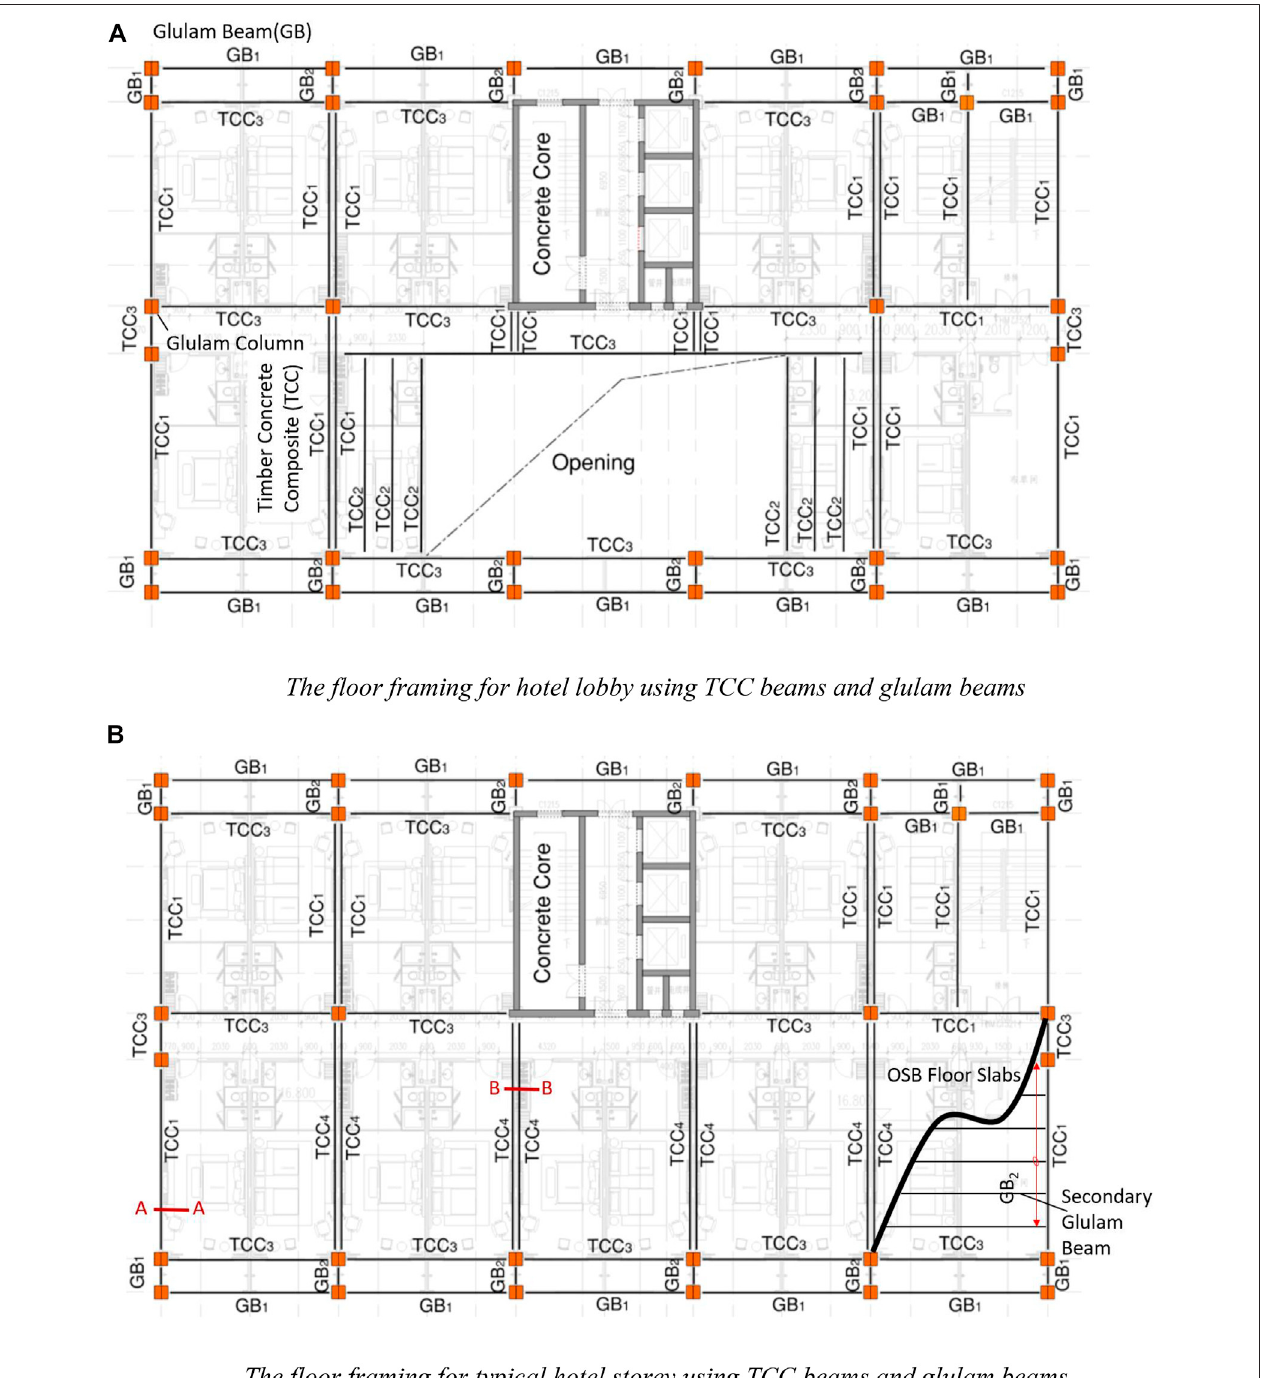
FIGURE 5 | Floor fl aming for TCC beam and design